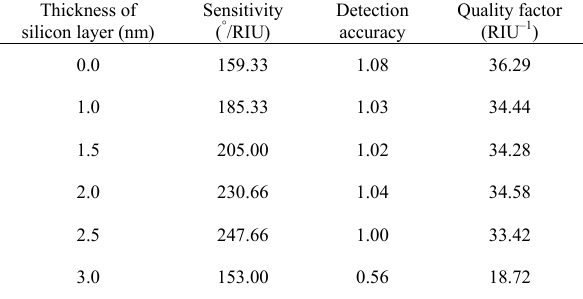
Table 4 Effect of the silicon layer thickness at the operating wavelength 632.8 nm on the sensitivity, detection accuracy, and quality factor of the proposed SPR sensor, i.e.,